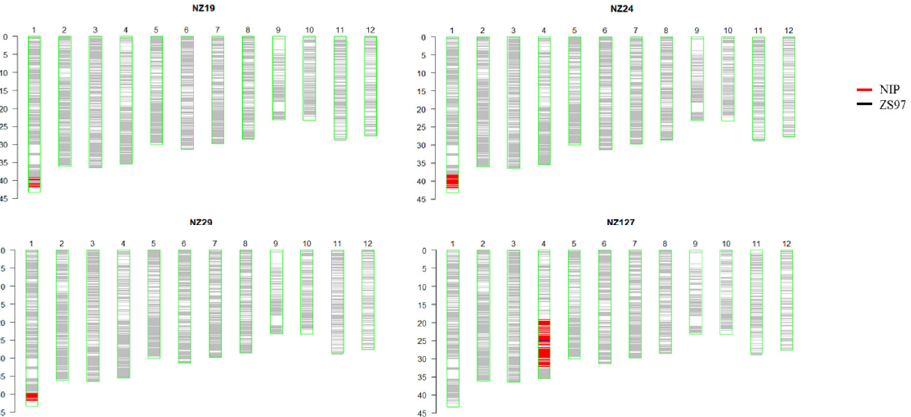
Figure 4. Array chip information of the four selected non-storable NILs. NIP introgressed segment is shown in red, and the gray background is the background material ZS97.